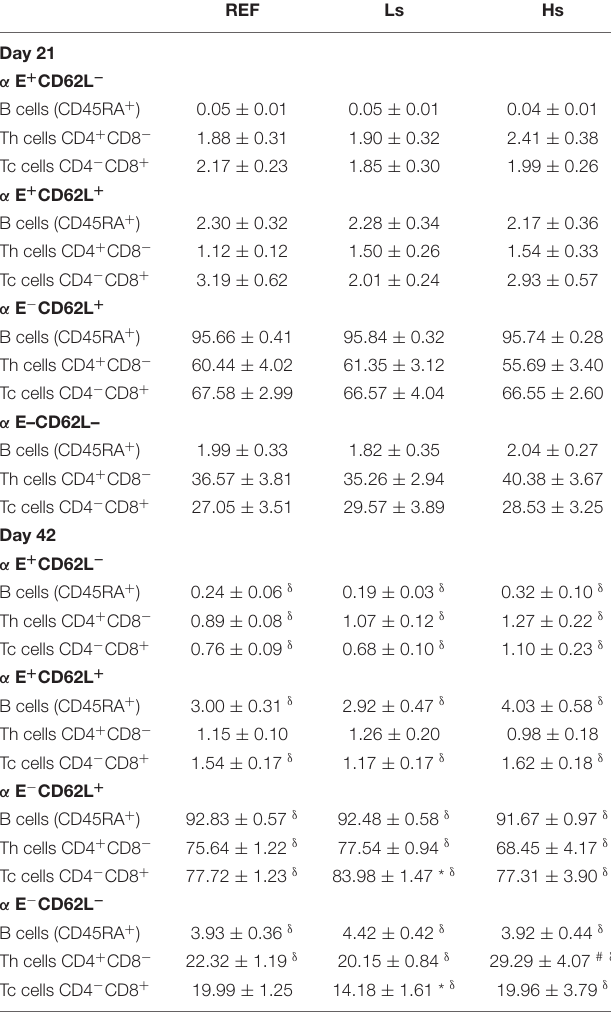
TABLE 4 | Expression of the integrin α E and the selectin CD62L in Th, Tc, and B lymphocytes in the spleen at the end of the supplementation (day 21 of life) and 3 weeks later (day 42 of life).